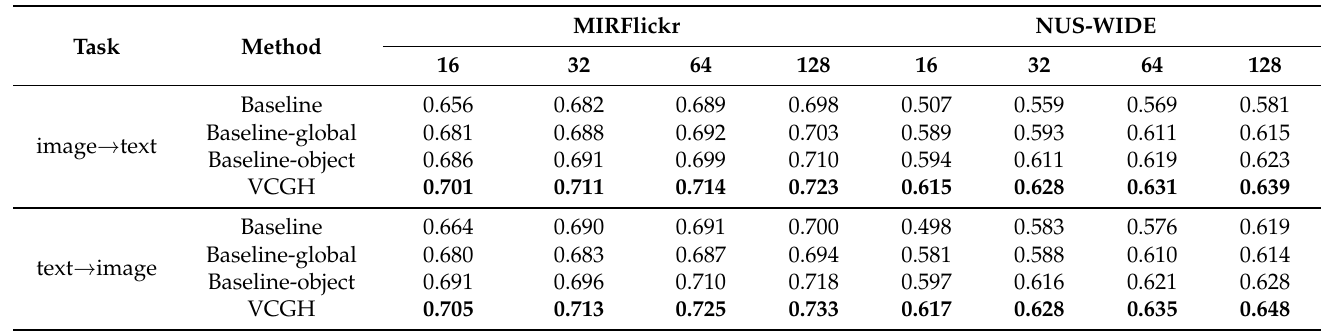
Table 3. The MAP scores by using different variants of the proposed VCGH on MIRFlickr and NUS-WIDE. The best results are highlighted in